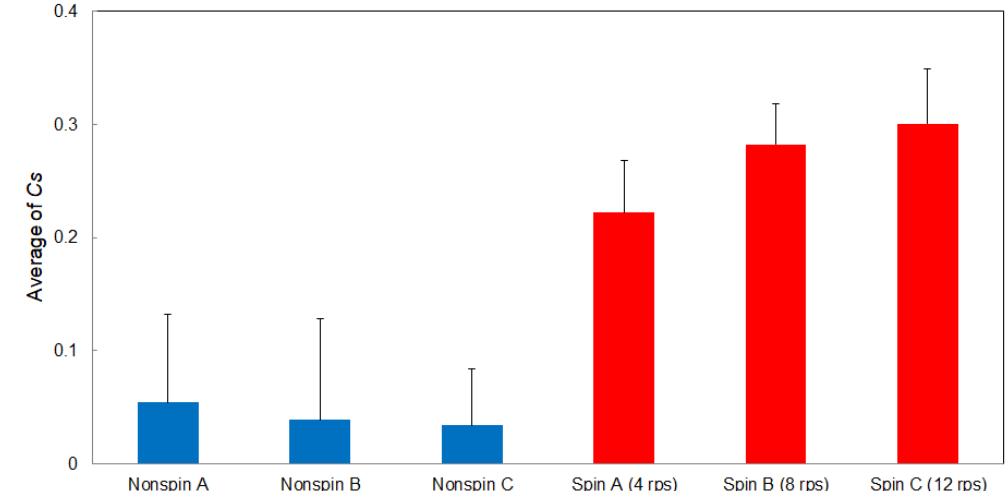
Figure 10. Comparison of the average side force coefficients ( Cs ) of nonspinning and spinning soccer balls (p < 0.01). The Re values in the case of Nonspin A, Nonspin B, and Nonspin C are 1.25 × 10 5 , 2.80 × 10 5 , and 4.00 × 10 5 , respectively, and the Re values in the case of Spin A, Spin B, and Spin C are 4.25 × 10 5 (spin rate = 4, 8, and 12 rps, respectively).